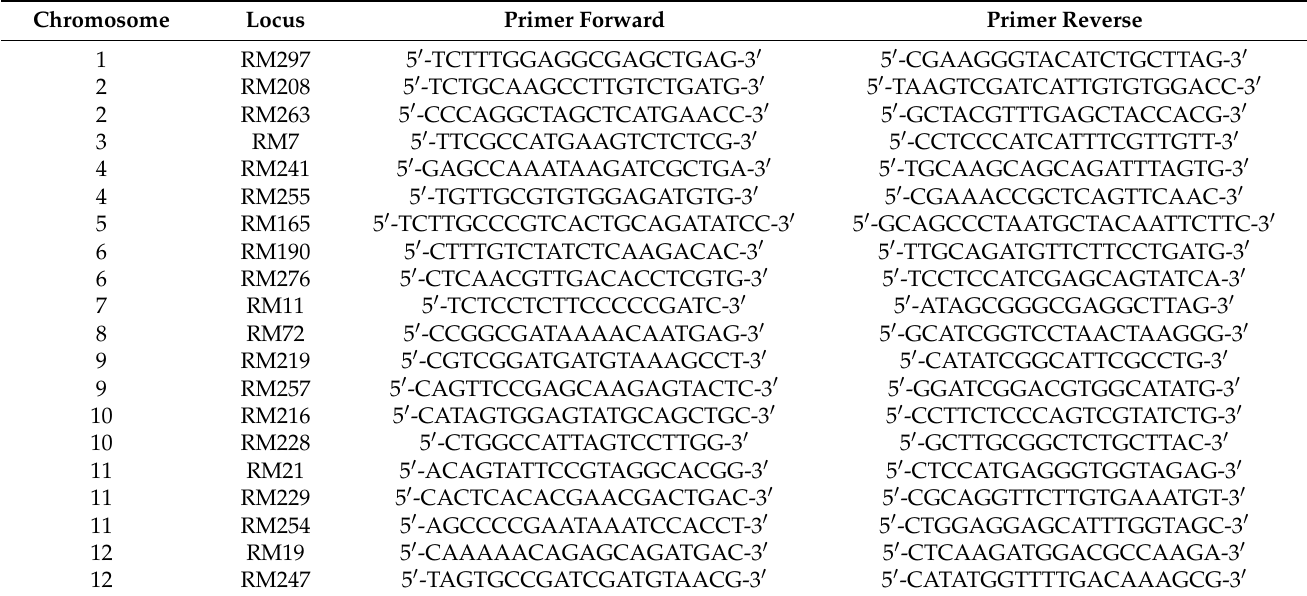
Table 4. Results of SSR primer